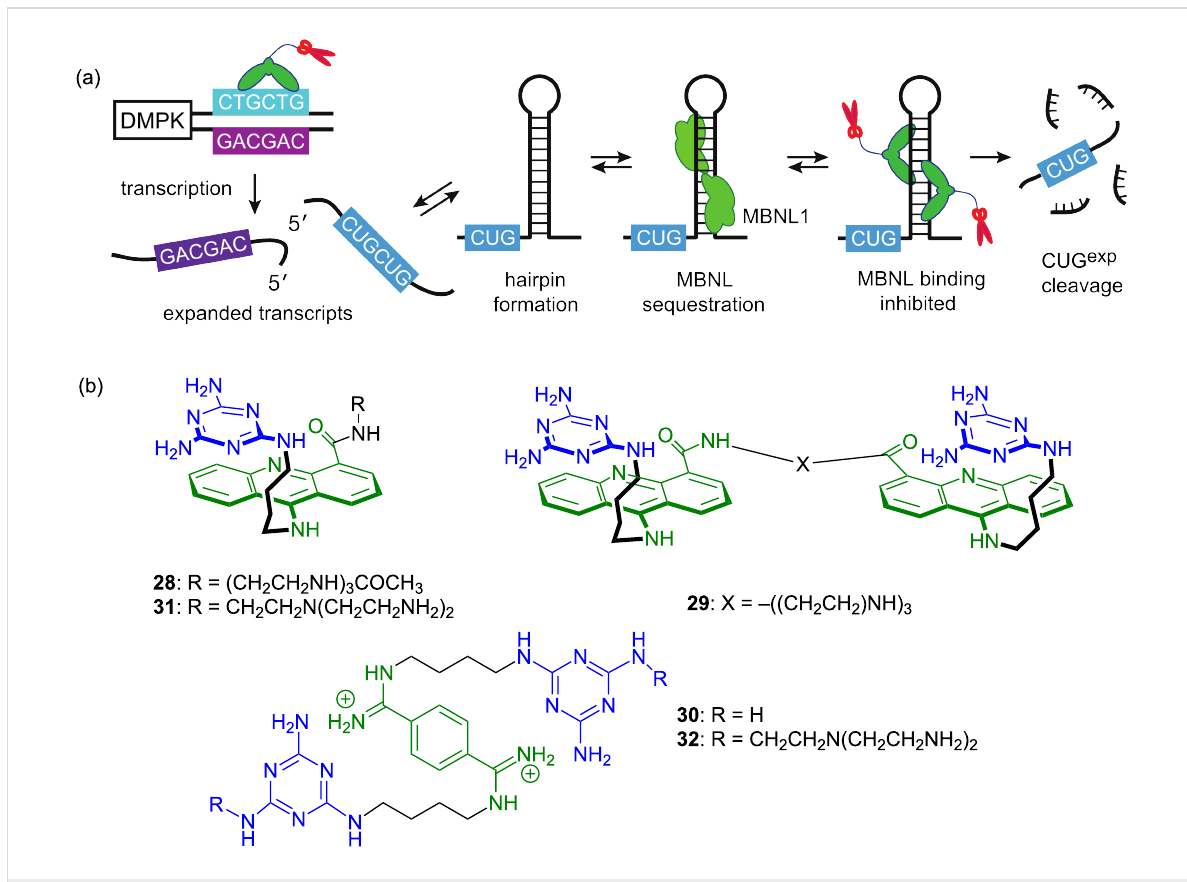
Figure 9: (a) CTG trinucleotide repeat expansion in DMPK gene produces expanded transcripts, one which CUG exp sequesters splicing regulator MBNL1. Three modes of disease intervention: binding to CTG exp to inhibit transcription, binding to CUG exp to inhibit MBNL1 binding, and RNase-like cleavage of CUG exp . (b) Ligands 28 – 32